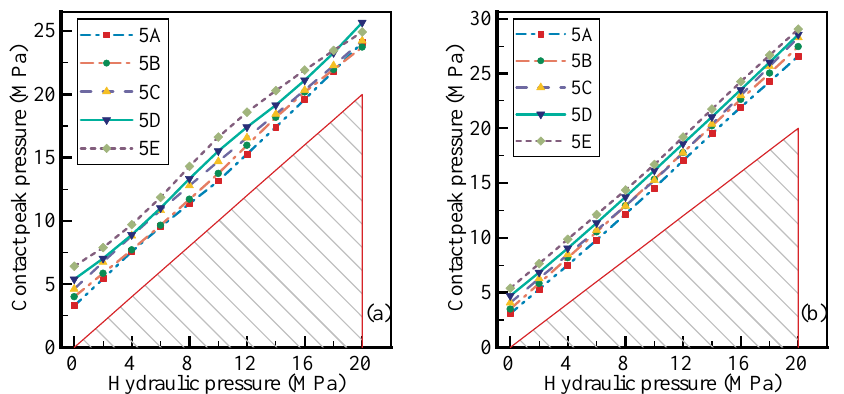
Figure 10. Comparison of hydraulic pressure. The contact peak pressure under different hydraulic pressures are shown in ( a ) for piston rod side and in ( b ) for groove side. Five groups simulation are compared, with five different pre-compression rates coded from A to E, and code 5 represents for the section diameter of the rubber ring (value is 7 mm). And failure zone is plotted to evaluate the sealing